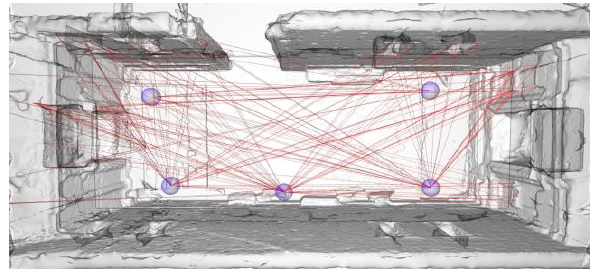
Figure 12: Perspective view of the orientation network of the five internal panoramas in the final 3d model.